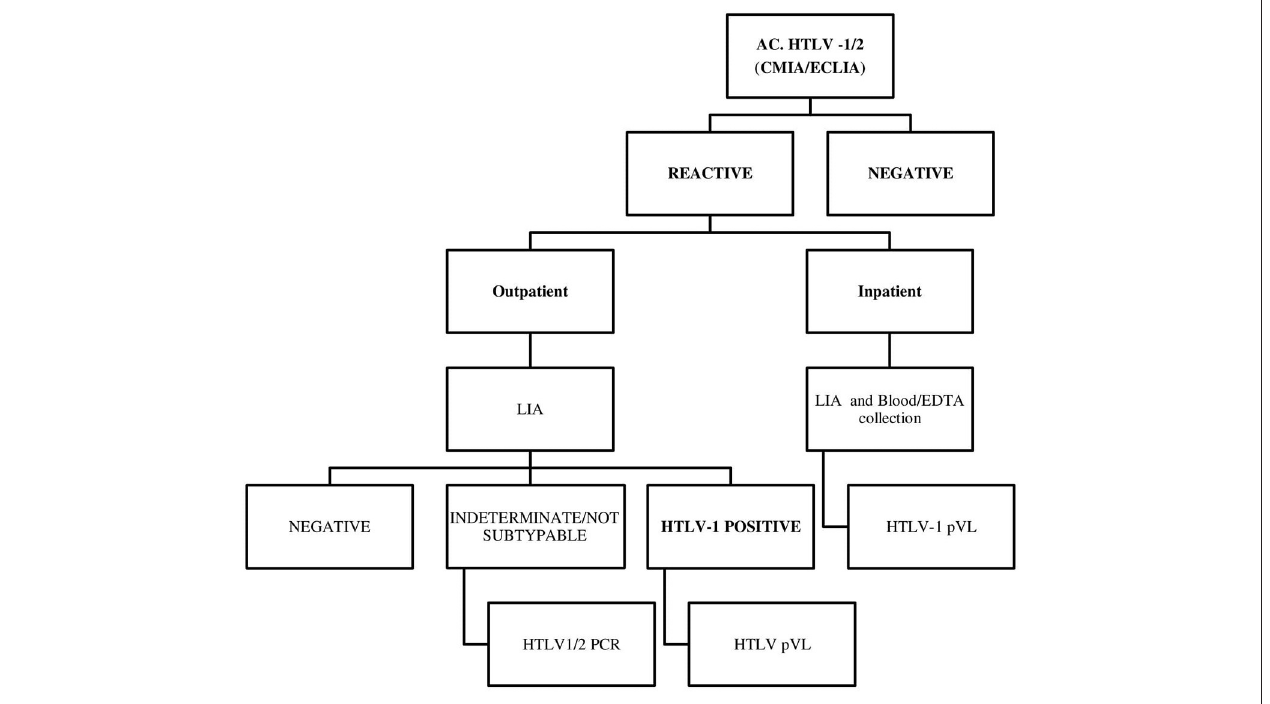
FIGURE 2 | A human T-cell lymphotropic virus (HTLV) diagnostic